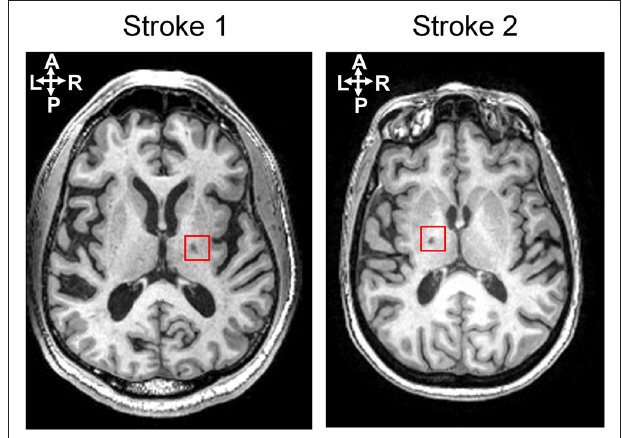
FIGURE 1 | Lesion locations for two stroke subjects shown on an axial slice of the T1-weighted anatomic images.